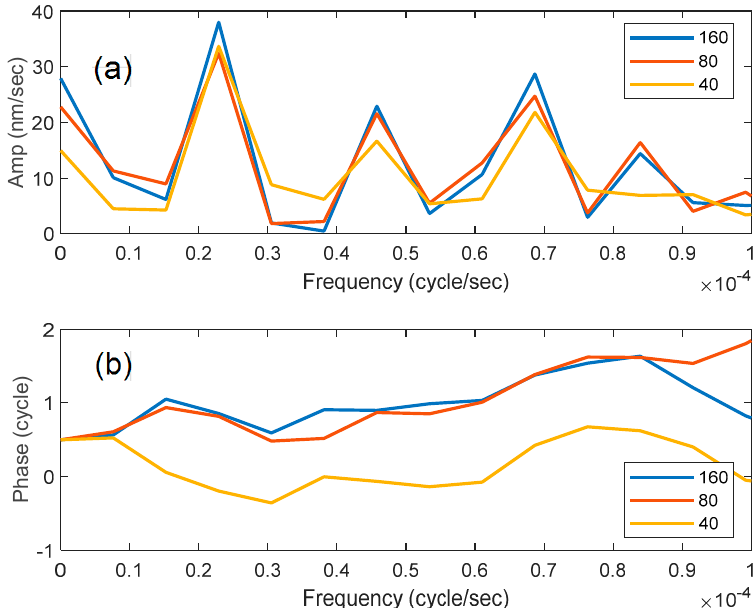
Figure 4. FFT spectra of displacement rate as a function of signal stacking: 40, 80, and 160 channels, ( a ) amplitude spectrum, ( b ) phase spectrum.